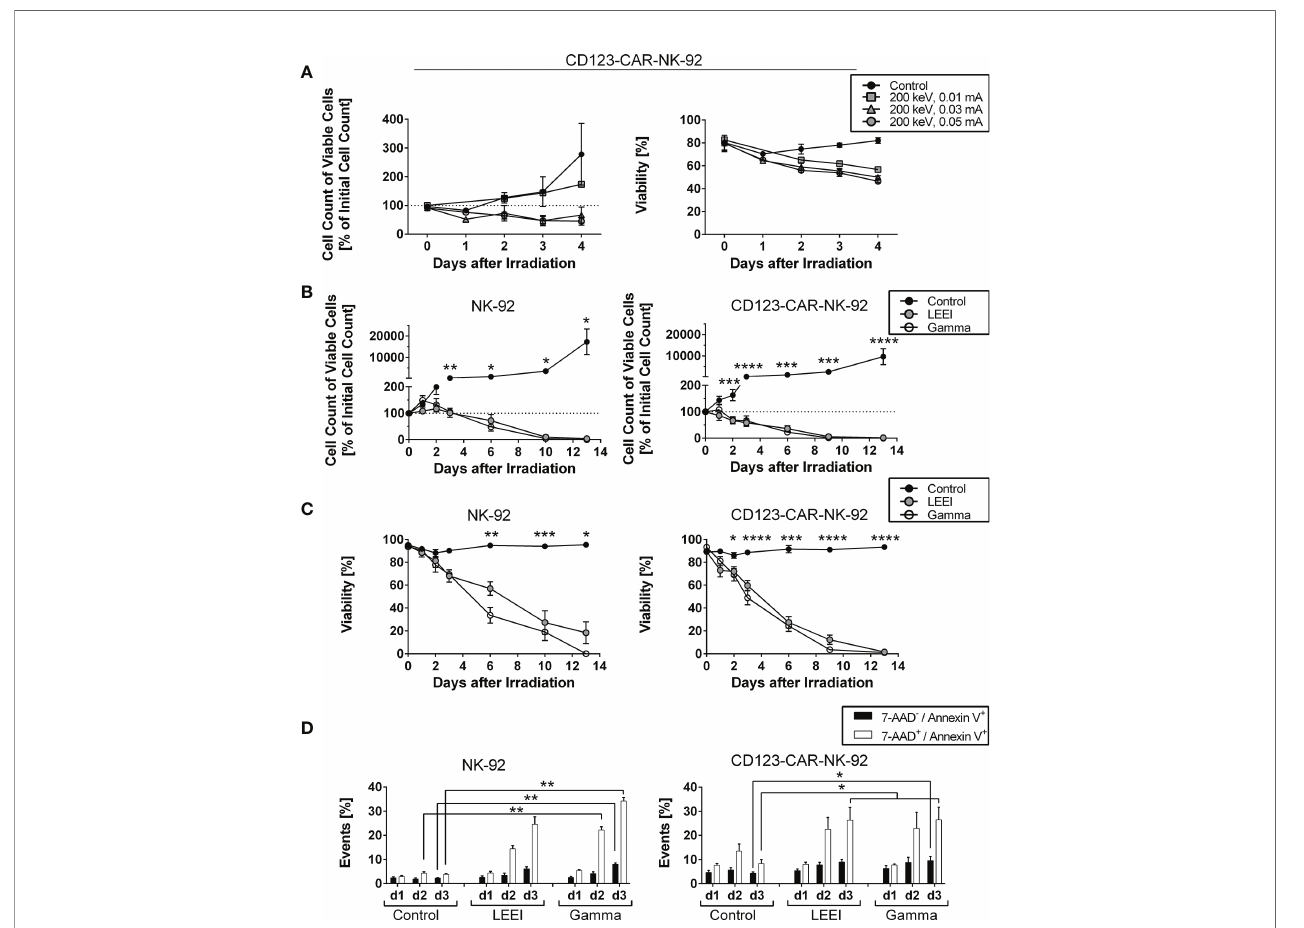
FIGURE 1 | Cell proliferation of NK-92 and CD123-directed CAR-NK-92 is fully inhibited by gamma irradiation and LEEI. (A) Cell count of viable CD123-CAR-NK-92 cells (left) and viability (right) were determined for 4 days for non-irradiated cells (black circles, n = 3) and LEE-irradiated cells at 200 keV and 0.01 mA (grey squares, n = 1), 0.03 mA (grey triangles, n = 3) or 0.05 mA (grey circles, n = 3) on an automated cell counter (CASY). (B) Cell count of viable NK-92 (left, n = 5) and CD123- CAR-NK-92 cells (right, n = 9) was determined for 13 days after irradiation for non-irradiated cells (black), LEE-irradiated cells (grey) and gamma-irradiated cells (white) on an automated cell counter (Countess II). (C) Viability was measured by trypan blue staining on an automated cell counter (Countess II) for 13 days after irradiation of NK-92 (left, n = 5) and CD123-CAR-NK-92 cells (right, n = 9). Non-irradiated cells (black) were compared to LEE-irradiated cells (grey) and gamma- irradiated cells (white). (D) Flow cytometry analysis of LEE- or gamma-irradiated NK-92 (left, n = 4) and CD123-directed CAR-NK-92 (right, n = 7) cells after 7-AAD and Annexin V staining. 7-AAD - /Annexin V + (black) and 7-AAD + /Annexin V + (white) subpopulations are shown. All values are indicated as means ± SEM, statistical signi fi cance is symbolized by asterisks (* for p ≤ 0.05, ** for p ≤ 0.01, *** for p ≤ 0.001, and **** for p ≤ 0.0001, ANOVA or Kruskal-Wallis test adjusted for multiple comparisons by Dunn ’ s